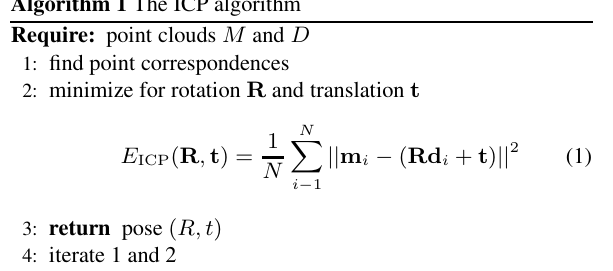
Algorithm 1 The ICP algorithm